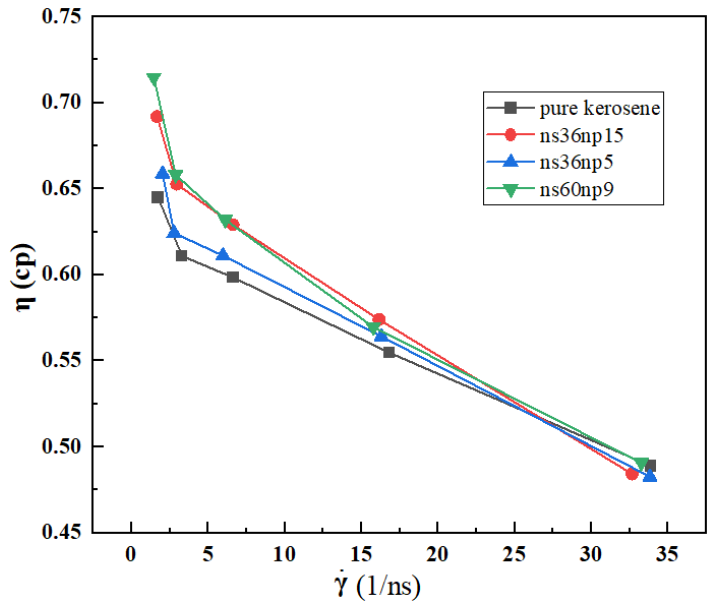
Figure 4. Dependence of viscosity η on shear rate ̇ for pure kerosene and DRA—kerosene